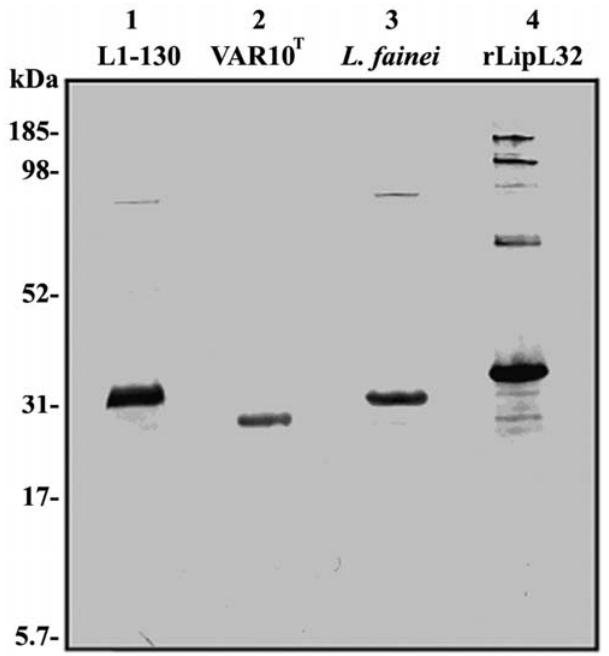
Figure 4. Western immunoblot of Leptospirainterrogans serovar Copenhageni strain L1-130, ‘‘L.licerasiae’’ serovar Varillal, and L.fainei serovar Hurstbridge using rabbit polyclonal antisera to recombinant LipL32 of L. kirschneri serovar Grippotyphosa. rLipL32, recombinant LipL32 of L. kirschneri serovar Grippotyphosa produced in E. coli .